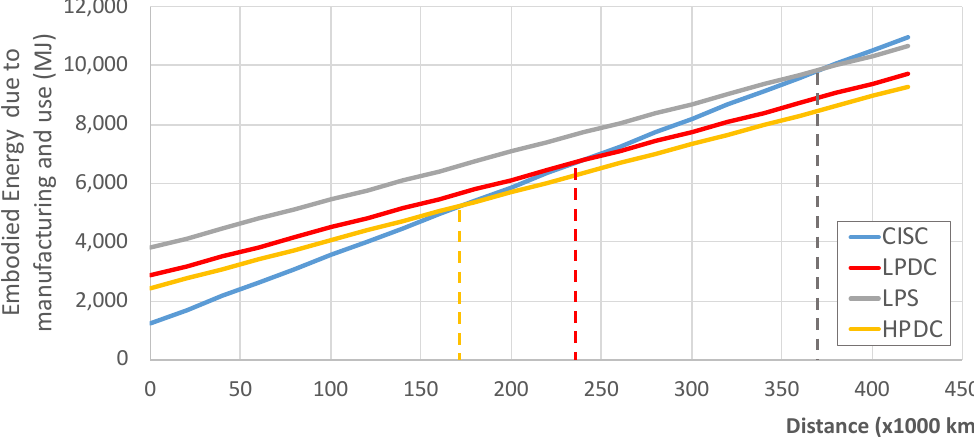
Figure 24. Break-even distance for paying back the lightweight material (for a diesel automotive vehicle of 1200 kg with an average consumption of 7l,100 km). Table 12. Parameters for the break-even distance (BED) calculation.